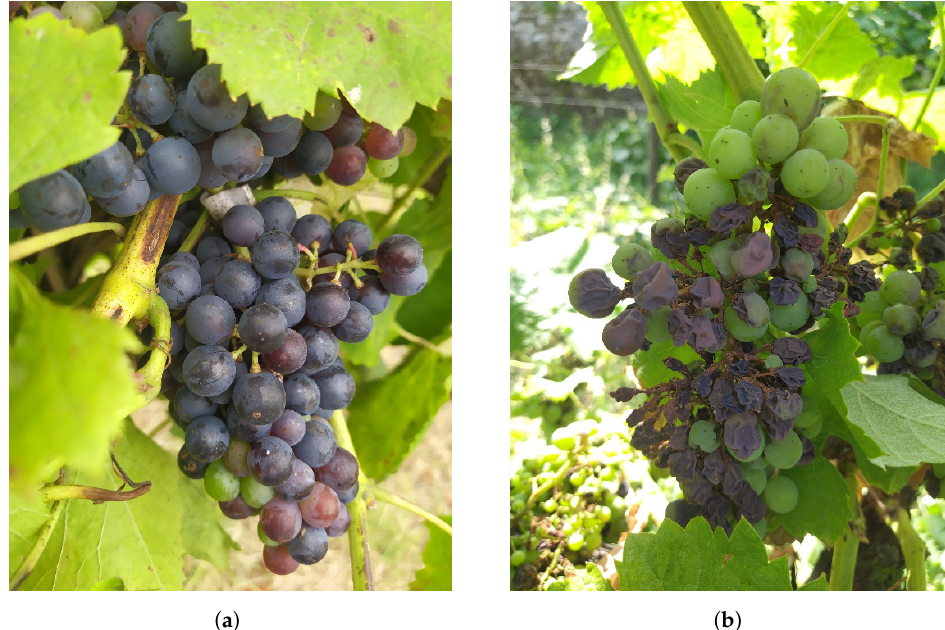
Figure 1. Examples of images from dataset. ( a ) Optimal grape bunch. ( b ) Damaged grape